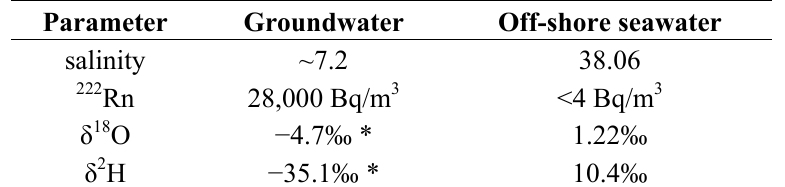
Table 1. Groundwater and off-shore seawater end-members for all applied